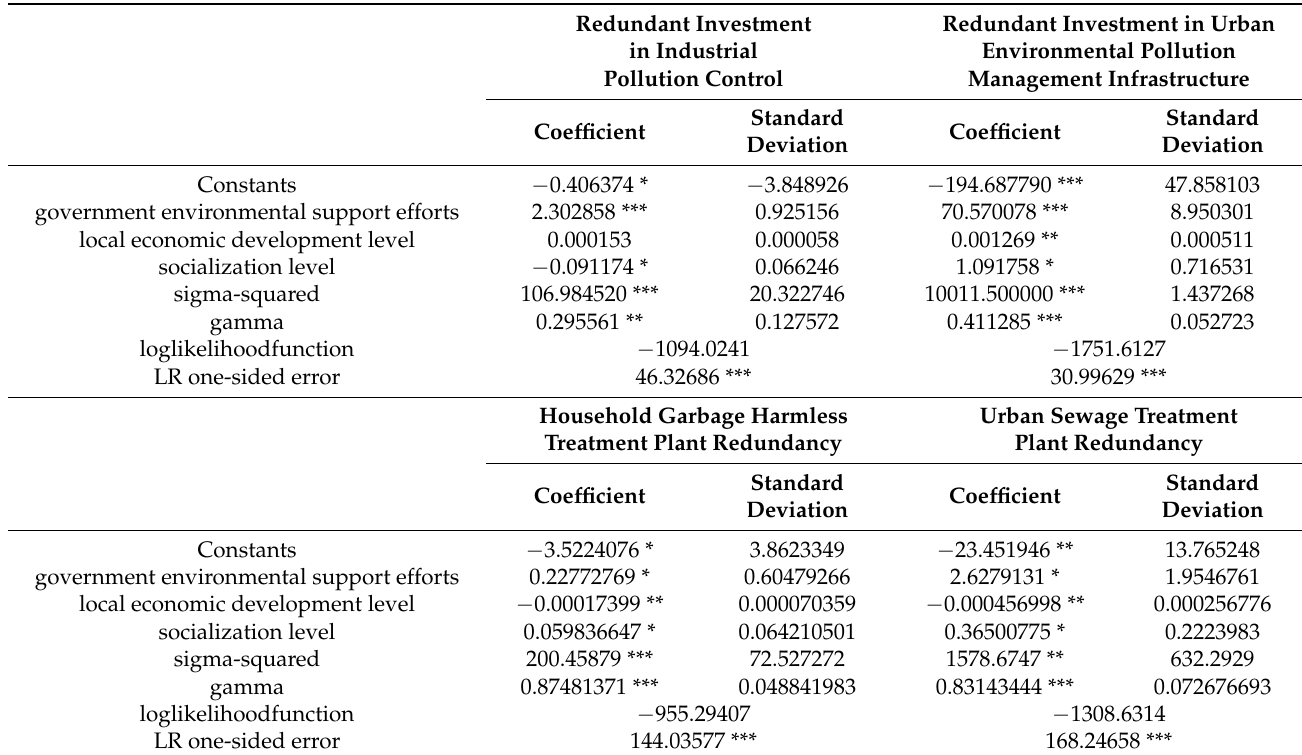
Table 3. Results of the second stage stochastic frontier